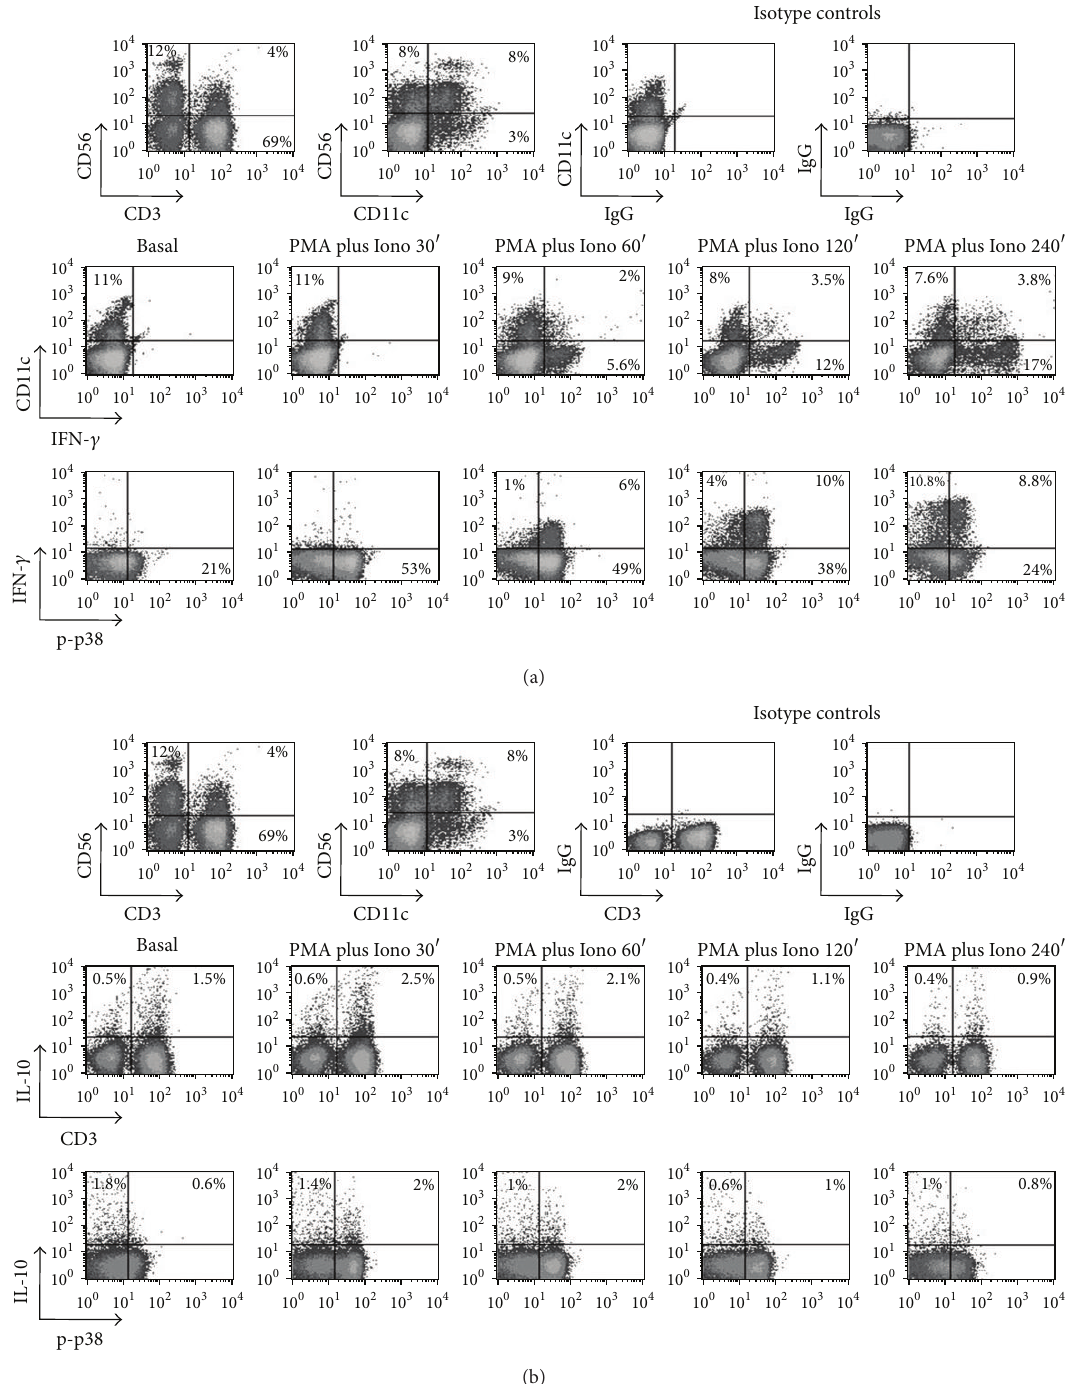
Figure 7: Simultaneous detection of IFN- 𝛾 , IL-10, and p-p38 MAPK expression in PBMCs cell subpopulations. (a) shows the plots for CD11c versus IFN- 𝛾 and IFN- 𝛾 versus p-p38. (b) shows the plots for CD3 versus IL-10 and IL-10 versus p-p38. In addition to IFN- 𝛾 , IL-10 can be detected under harsh methanol permeabilization conditions. IL-10 expression precedes that of IFN- 𝛾 and can be seen in both CD3+ and CD3 −